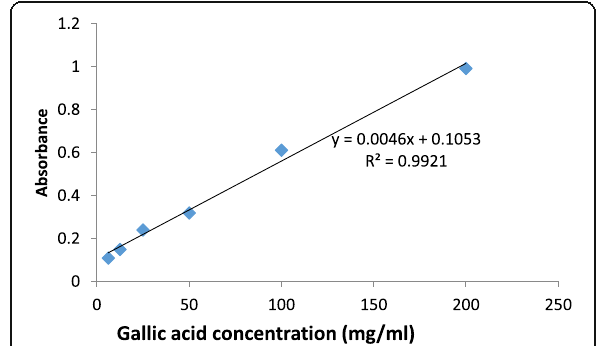
Fig. 1 Concentration-response curve of gallic acid standard Fig. 2 Concentration – response curve of quercetin standard